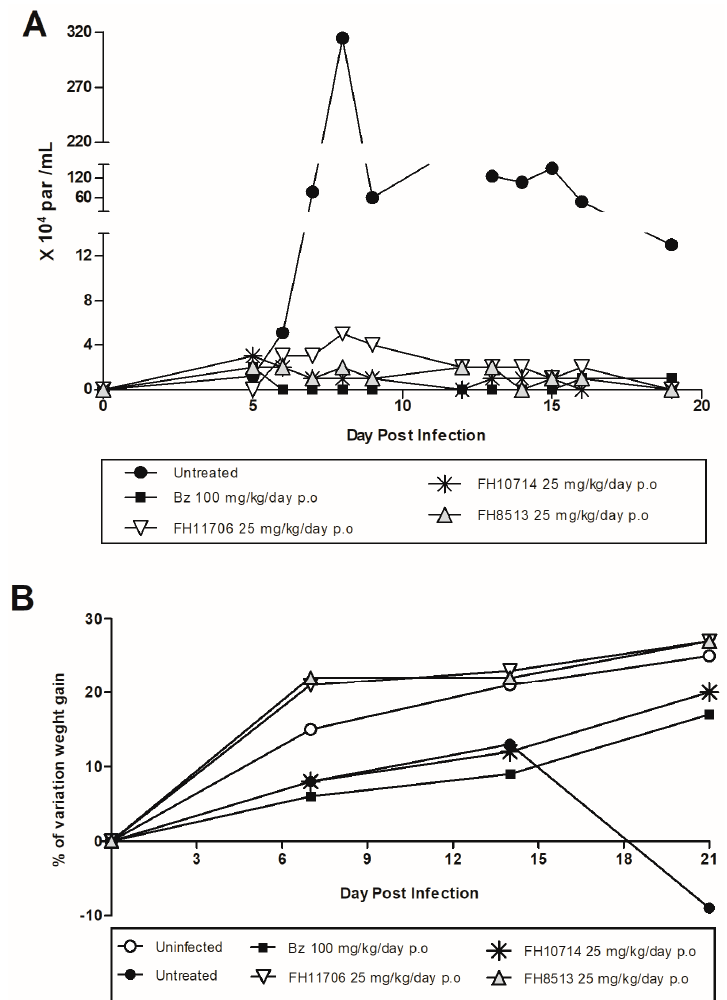
Figure 3. FH11706 , FH10714 , FH8513 and Bz activity on male Swiss mice infected with 10 4 blood- stream trypomastigotes (Y strain). ( A ) Parasitemia curve. ( B ) Percentage (%) of mouse weight vari- ation..